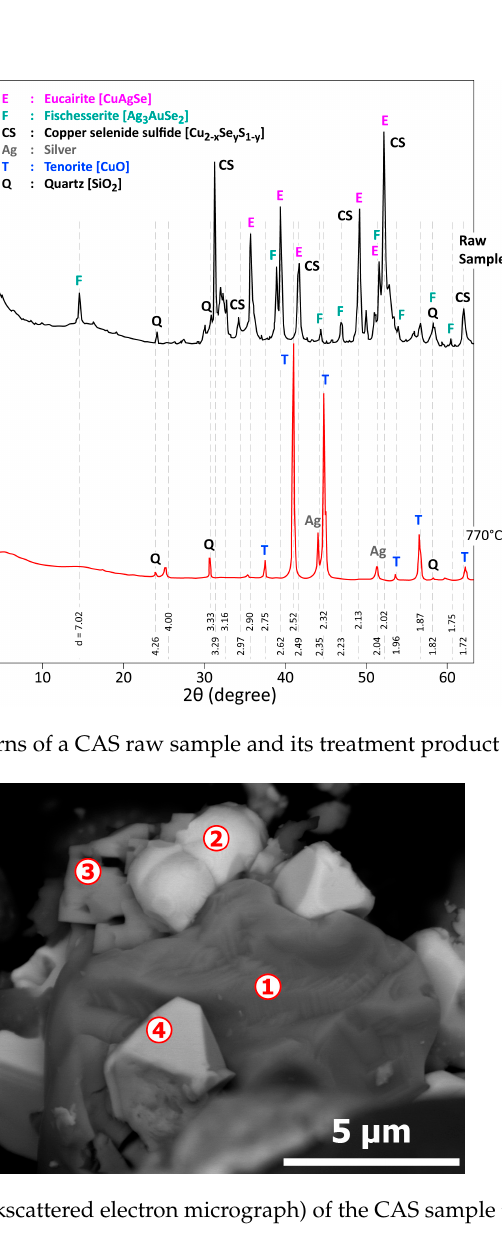
Figure 6. XRD patterns of the residues obtained during CAS sample treatment under air from 505 °C to 770 °C.